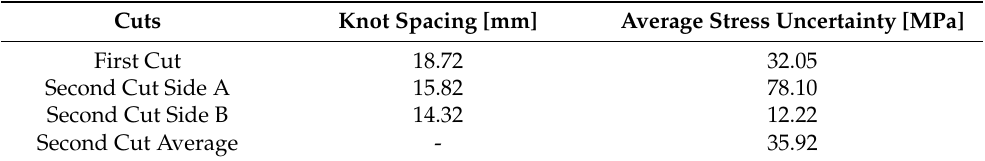
Table 4. Knot spacings of the cross sections’ largest dimension and average stress uncertainties for the first and second cut. Side A corresponds to the Inconel 625 side of the cut part, while side B is the Ti6Al4V side.